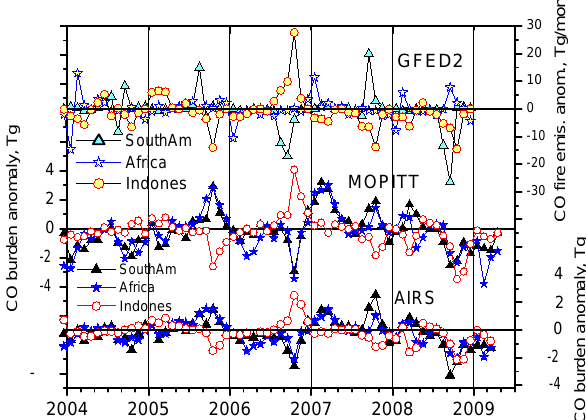
Fig. 13. Anomalies of CO fire emissions according to GFED2 and anomalies of CO burdens measured by MOPITT and AIRS for three regions since